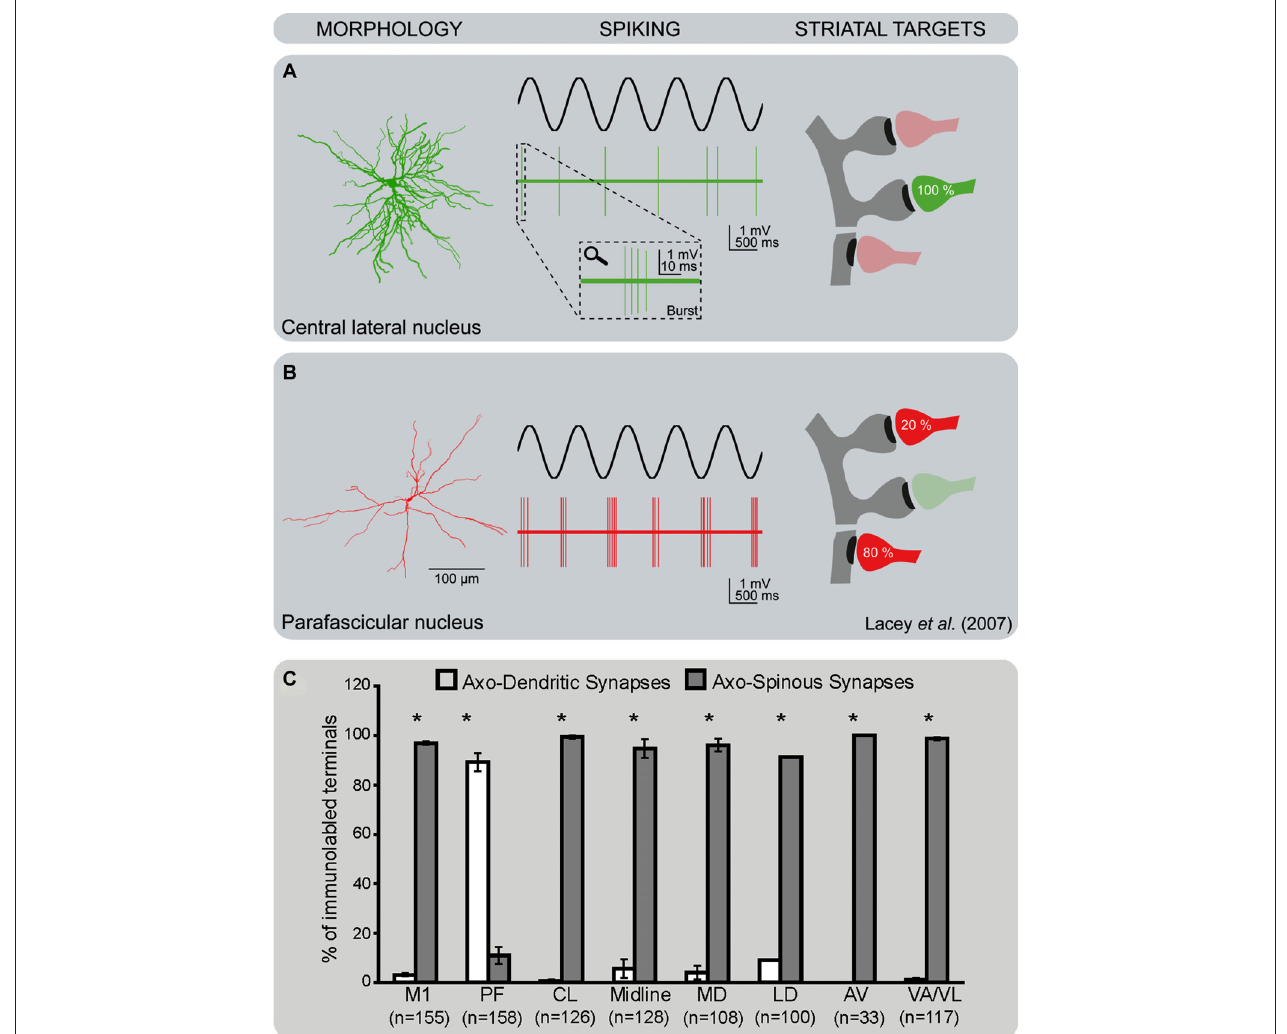
and more variable than those of central lateral neurons. At the ultrastructural level, terminals from the parafascicular nucleus predominantly target the dendritic shafts of striatal neurons (see Lacey et al., 2005, 2007 for more details). (C) Histogram showing the frequency of axo-dendritic vs. axo-spinous synapses formed by anterogradely labeled boutons from various thalamic nuclei and the primary motor cortex (M1) in the rat striatum. Note the striking difference in the pattern of synaptic connectivity of terminals from Pf vs. other thalamic nuclei (see Raju et al., 2006 for more